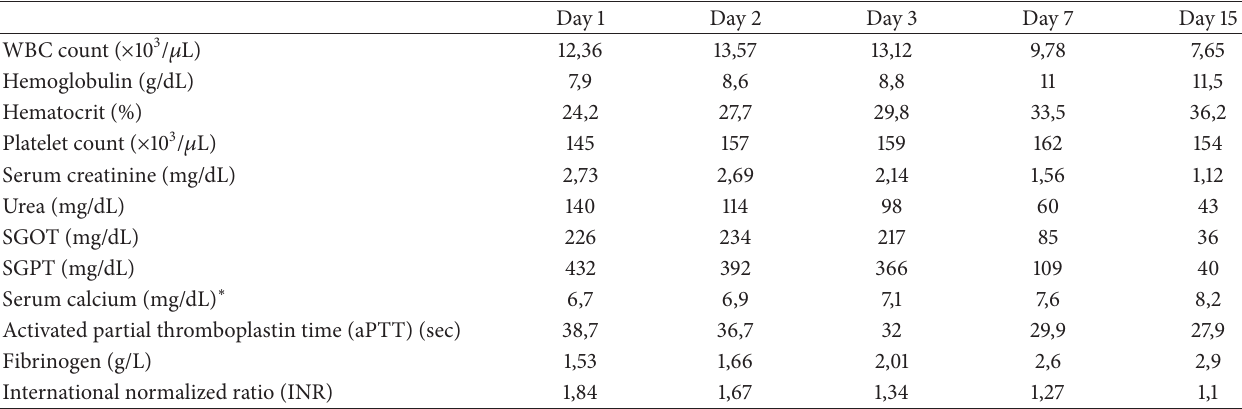
Table 1: Routine laboratory examination.